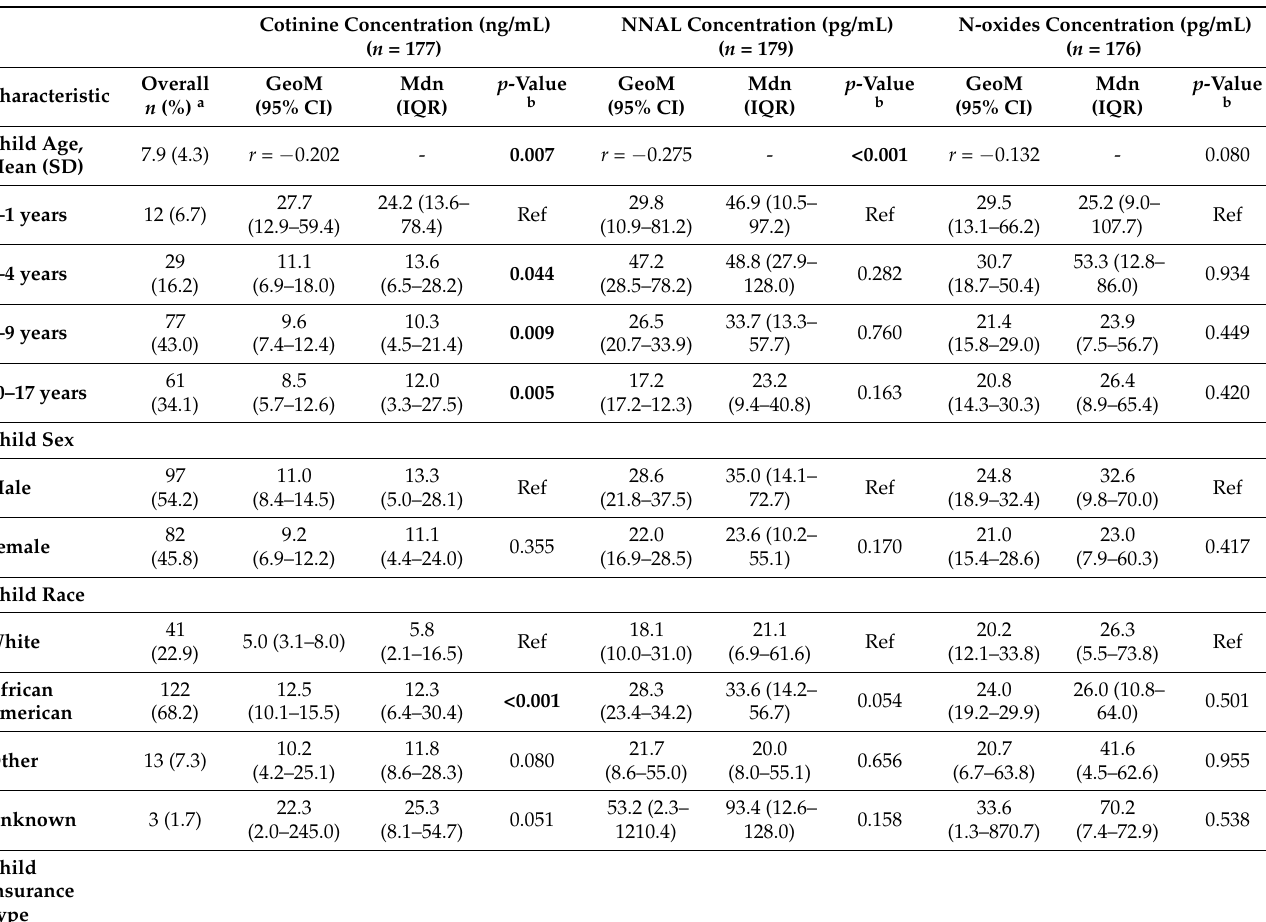
Table 1. Sociodemographics by Urinary Cotinine, NNAL, and N-oxides Levels of Pediatric Emergency Department and Urgent Care